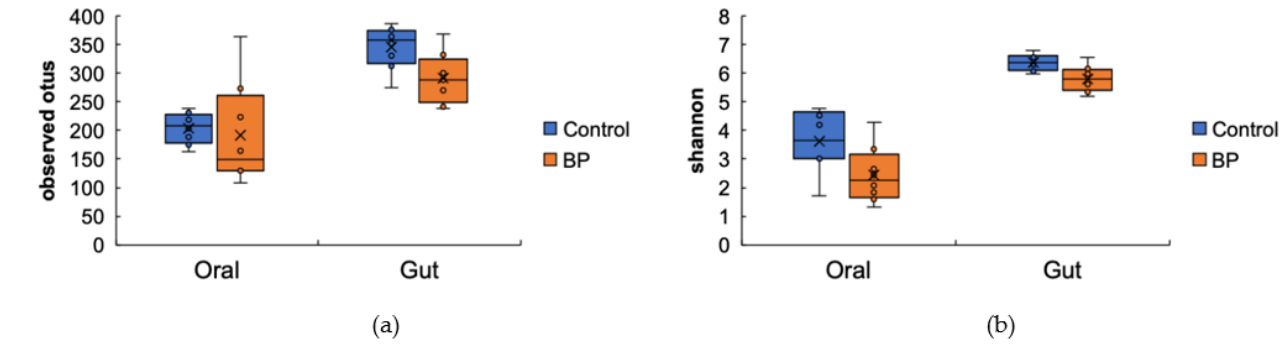
Figure 3 . Richness and diversity of the oral and gut bacterial species (alpha diversity). ( a ) The observed OTUs of gut bacterial flora were significantly higher in the control group than in the BP group ( p = 0.027; q = 0.027). ( b ) The Shannon of oral and gut bacterial flora was significantly higher in the control group than in the BP group ( p = 0.045; q = 0.045).